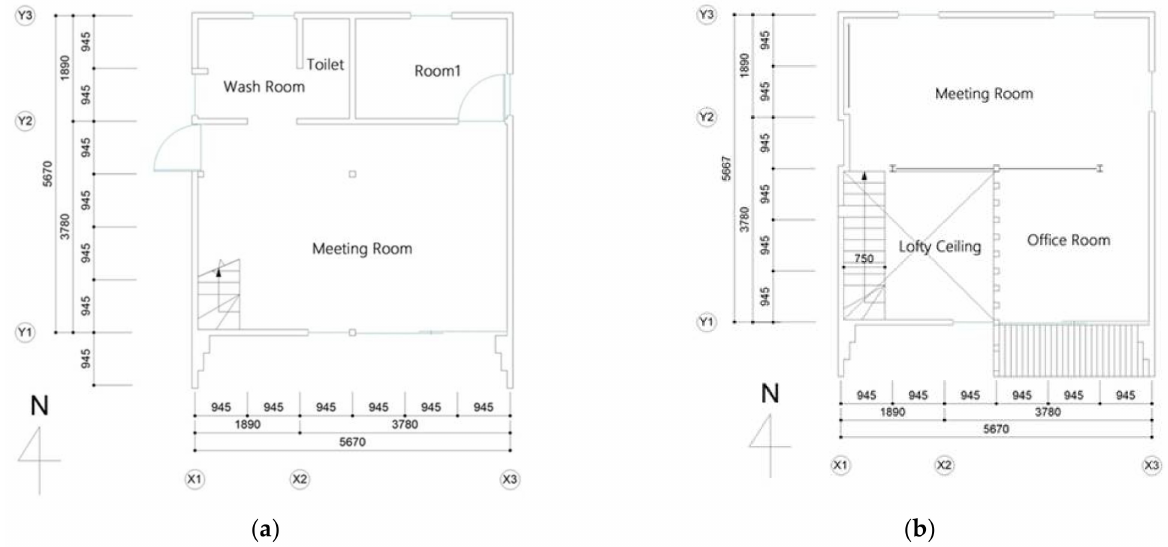
Figure 3. The two-story floor plan of the building: ( a ) the first floor; ( b ) the second floor.